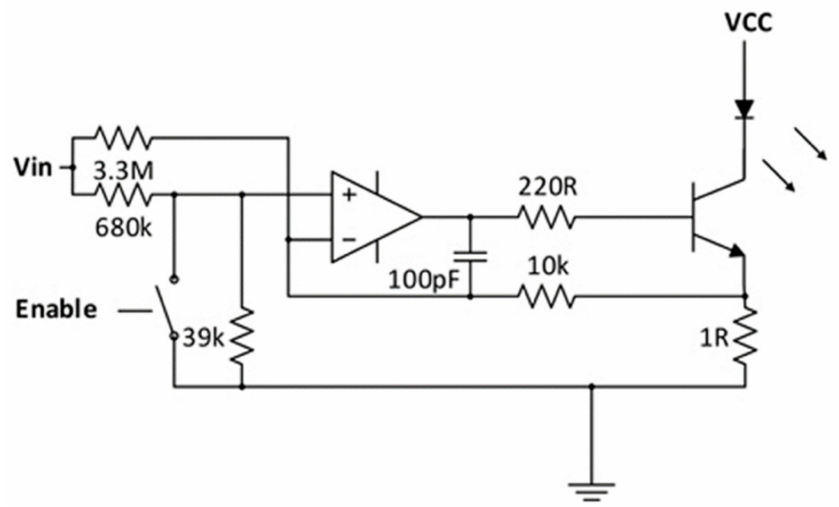
Figure 16. Current regulator circuit. (Reprinted from